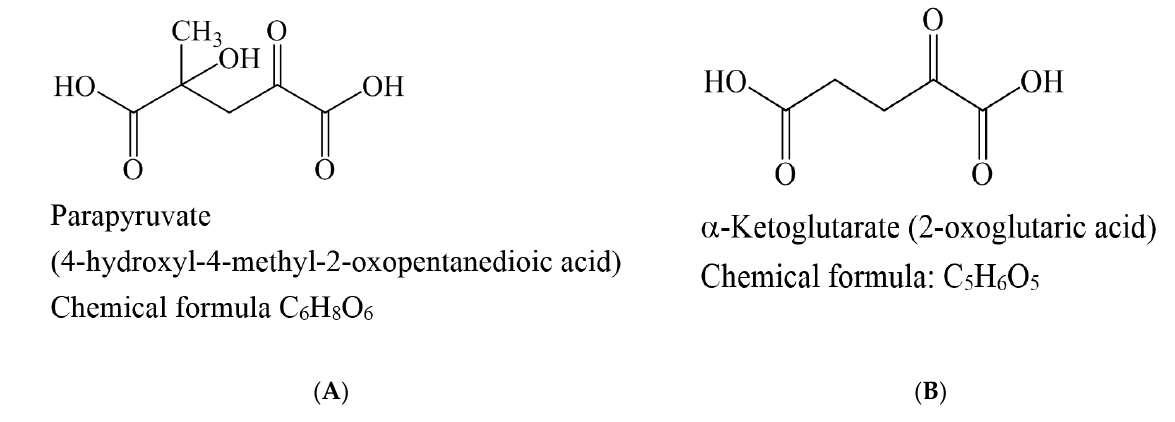
Figure 3. The structures of ( A ) parapyruvate and ( B ) α -ketoglutarate.